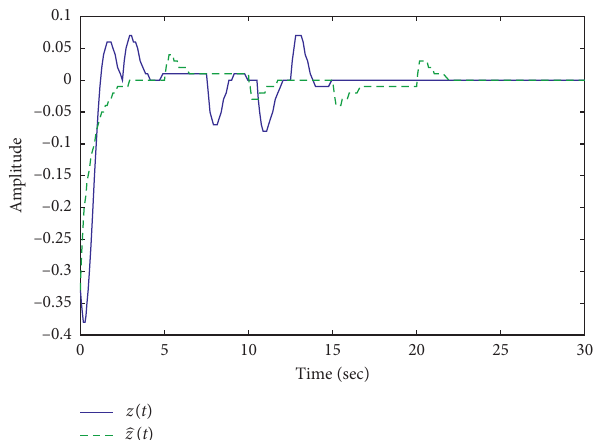
Figure 8: Response of the estimation error for